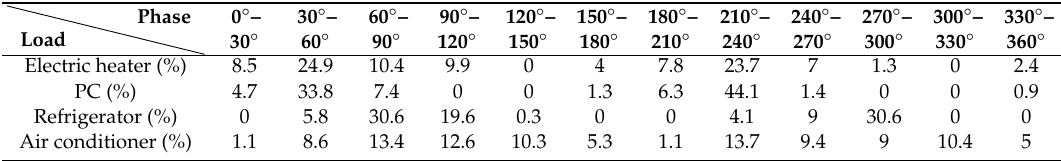
Table 1. Results of phase analysis.